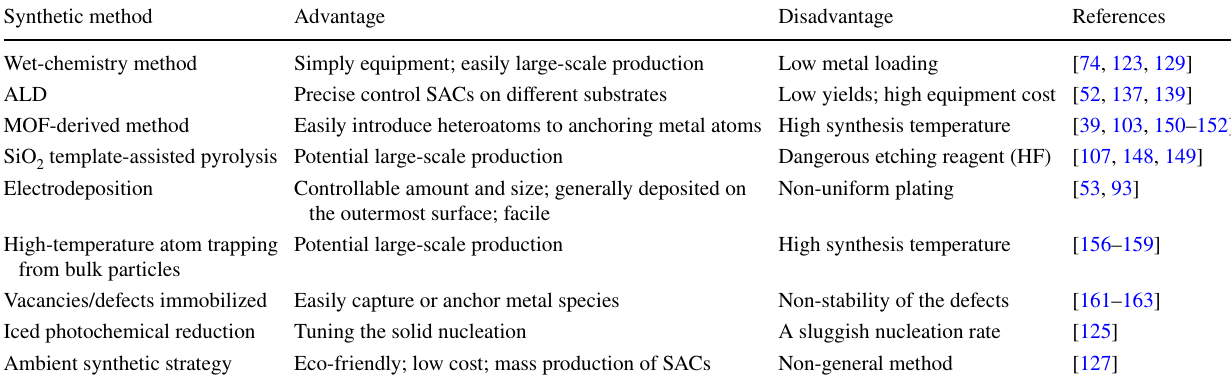
Table 1 Partial list of synthesis strategies for producing SACs Synthetic